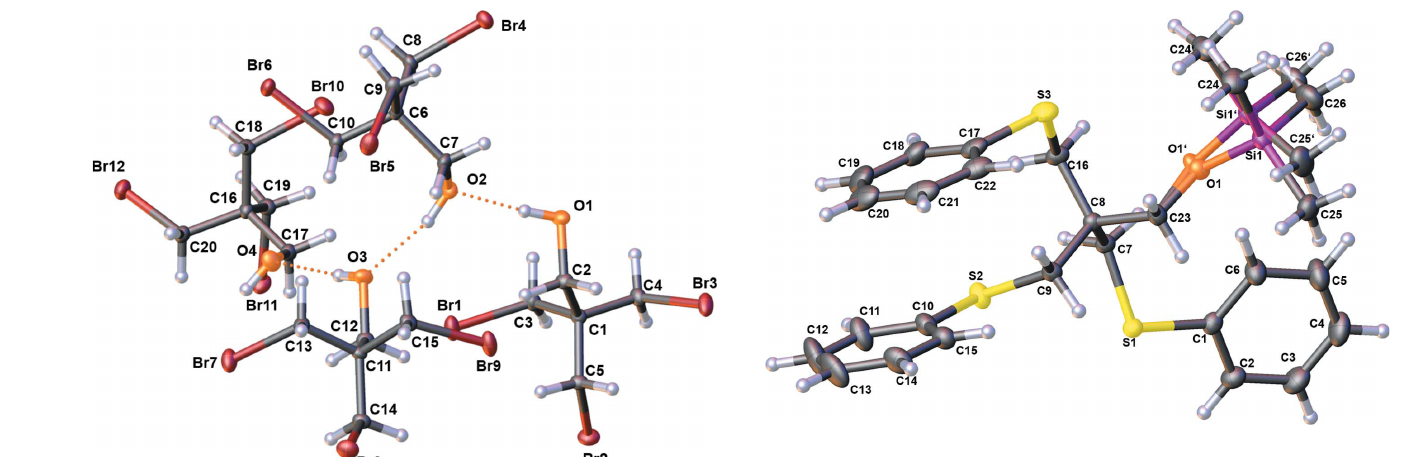
Figure 2 The molecular structure of silylated thioether ligand 3 with displacement ellipsoids drawn at the 50% probability level.